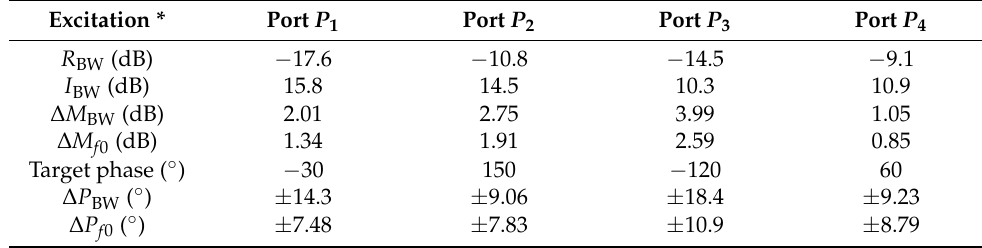
Figure 16. Measurements (––) vs. simulations (···) obtained using the EM model that account for the systematic errors: ( a ) reflection/isolation, ( b ) transmission, and ( c ) output-port phase differences. Table 4. Butler matrix 2: measured performance figures of the fabricated prototype.